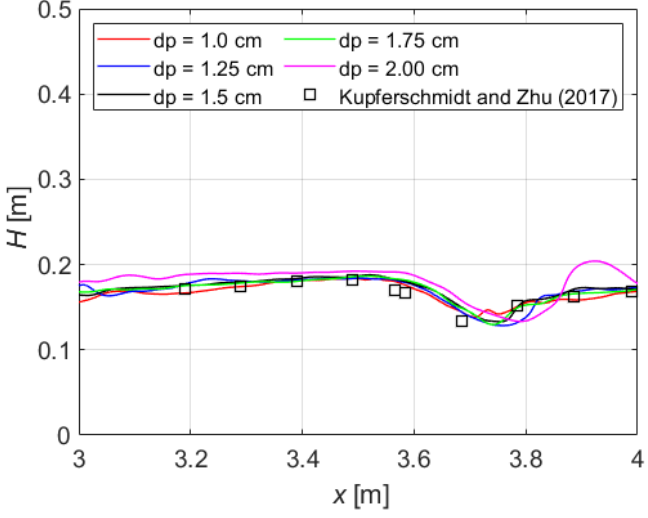
Figure 3. Centerline water-surface elevation along the selected section of HOR case for α = 0.01 and various dp .